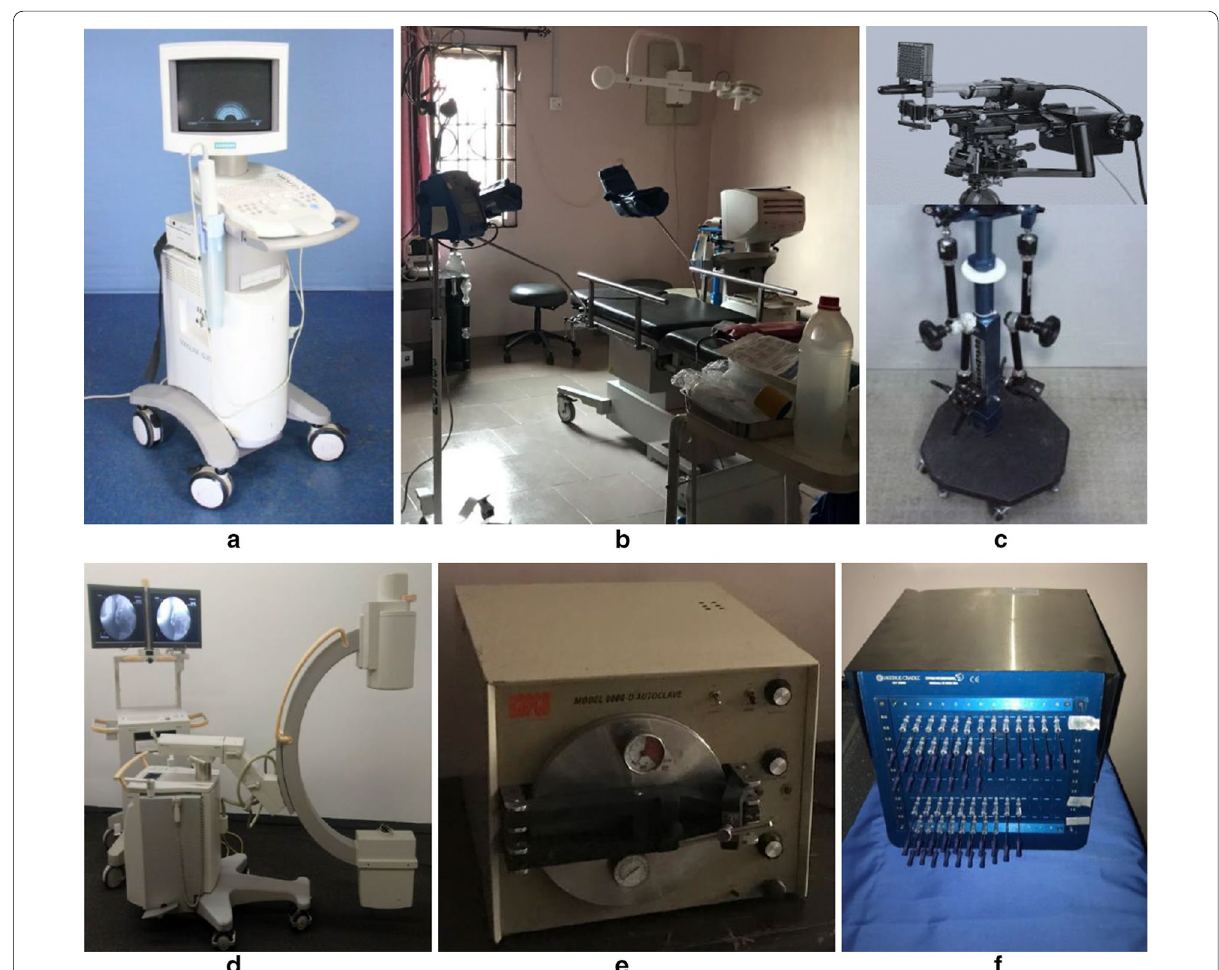
Fig. 2 Main technology components used to perform the first brachytherapy prostate implant procedures at the LA’Newton oncology Clinic, Benin City—Nigeria. A major technology component not included in the figure is the software, treatment planning system (TPS), used to calculate the dose distribution generated by the radioactive I-125